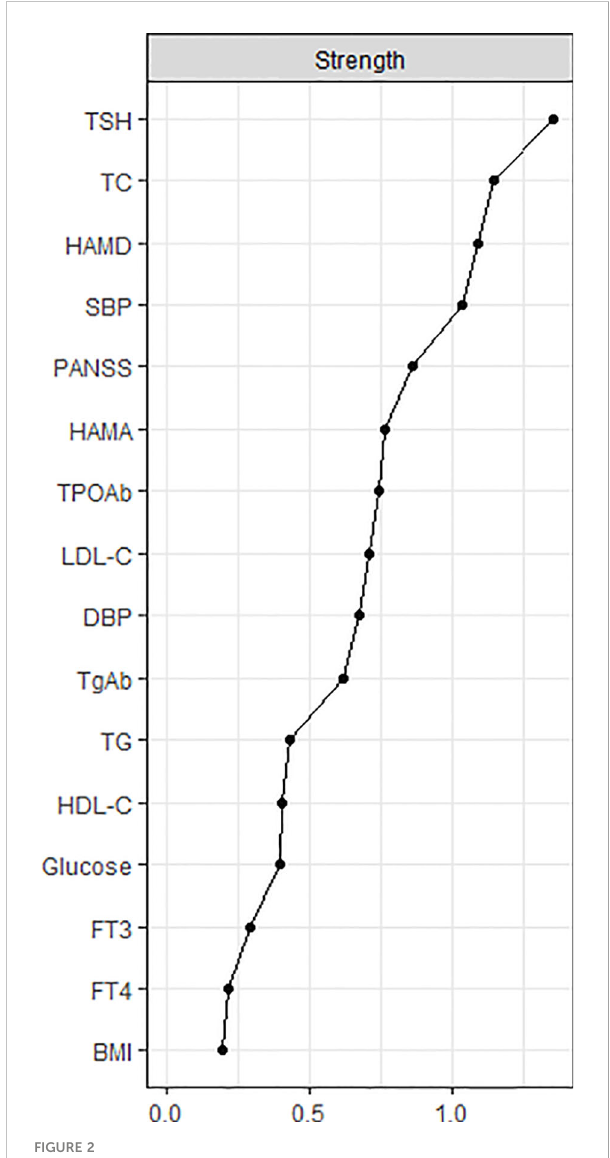
FIGURE 2 The central nodes of the network. The X-rays represented the strength of each node. Nodes with higher strength have stronger impact in other nodes within the network. HAMD, Hamilton Depression Rating Scale; HAMA, Hamilton Anxiety Rating Scale; PANSS, the Positive and Negative Syndrome Scale; TSH, thyroid- stimulating hormone; FT3, free triiodothyronine; FT4, free thyroxine; TgAb, antithyroglobulin; TPOAb, thyroid peroxidases antibody; TC, total cholesterol; HDL-C, high-density lipoprotein; LDL-C, low- density lipoprotein; TG, total triglycerides; BMI, body mass index.